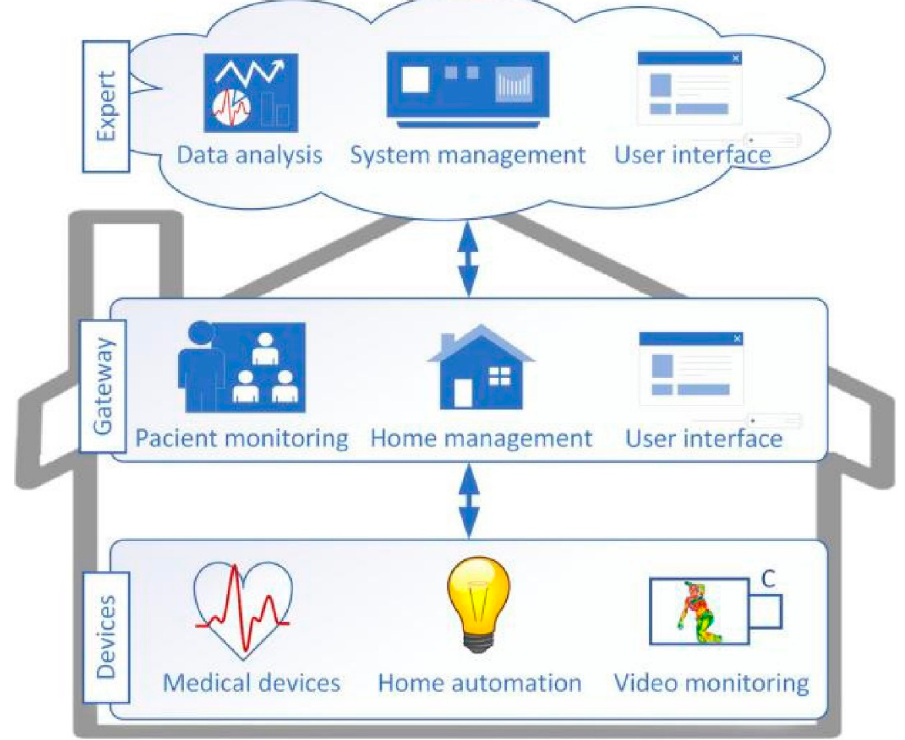
Figure 1. Conceptual architecture of the SmartCare system [37].